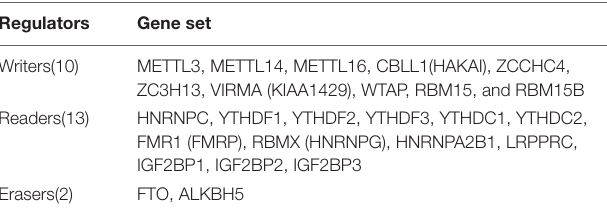
TABLE 2 | The components of m6A RNA methylation regulators in writer-, reader,- and eraser-complex.